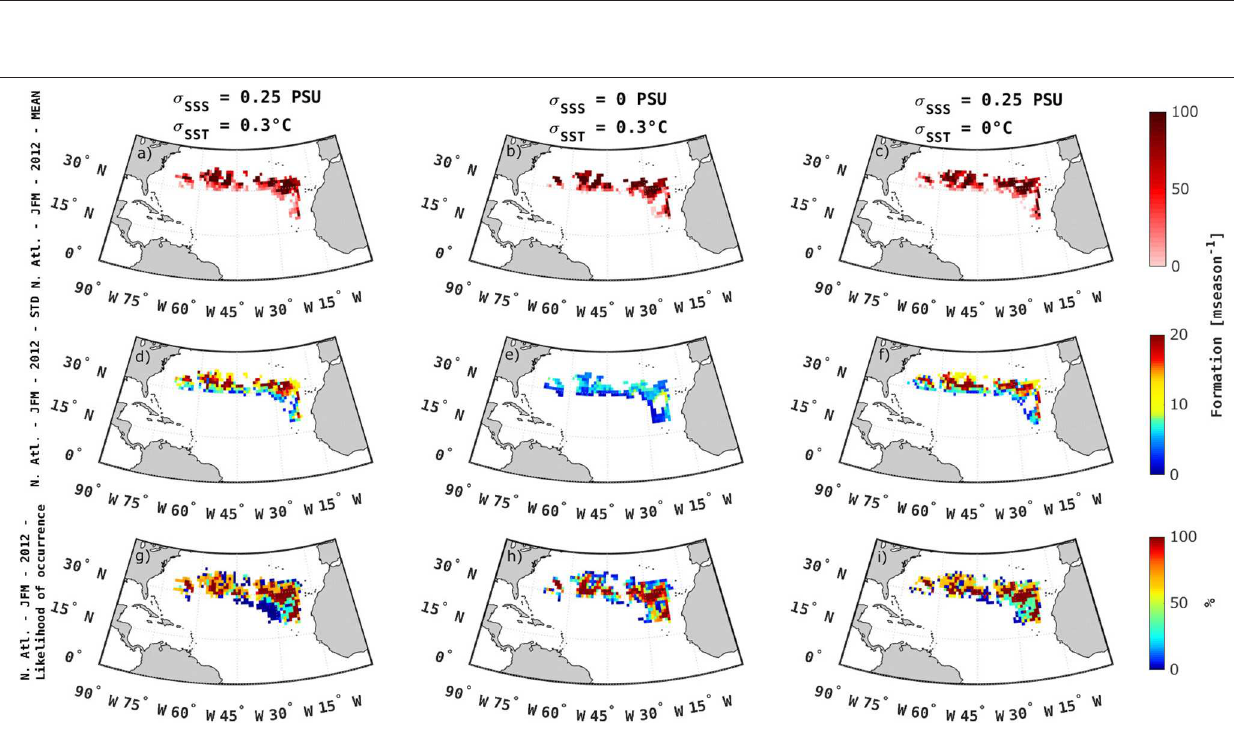
Frontiers in Marine Science |